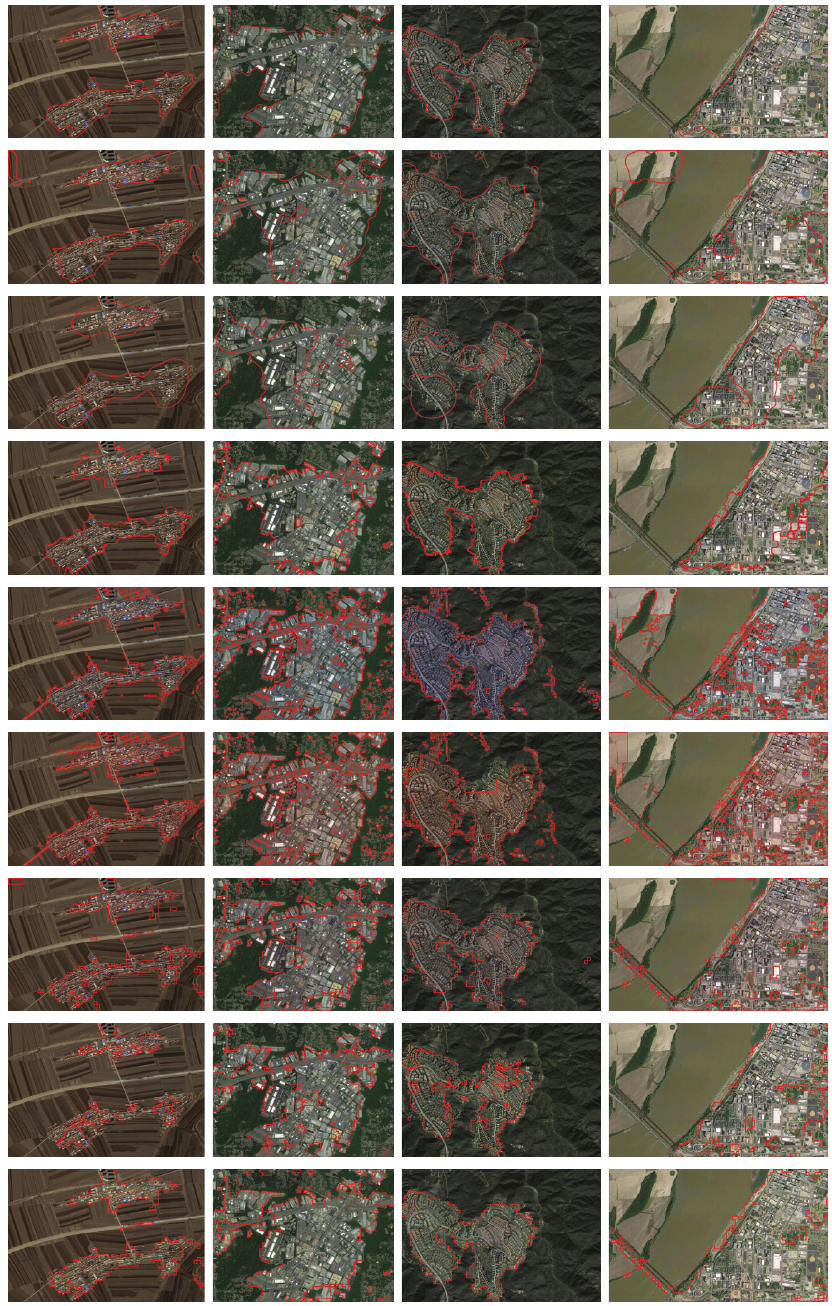
Figure 4. Qualitative illustration of different methods for urban area detection on four typical images of the Google Earth dataset. From left to right: #3 image (43.845 N, 125.084 E, 1.636 m/pixel, 952 × 1406), #7 image (35.271 N, 80.821 W, 2.905 m/pixel, 952 × 1236), #31 image (34.075 N, 118.551 W, 1.943 m/pixel, 952 × 1426) and #42 image (35.134 N, 90.064 W, 2.207 m/pixel, 952 × 1568). From top to bottom: ground (VWRD) [23], PCA + SVM, DCNNs + SVM, CNN [36] and our proposed